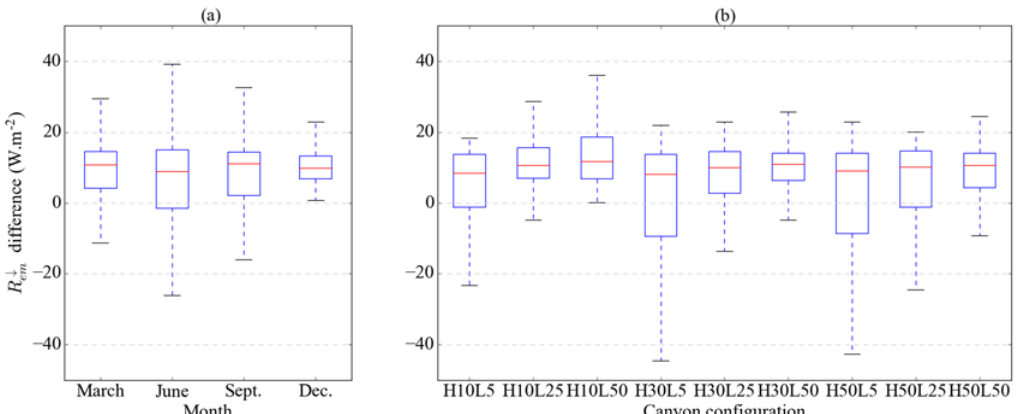
Figure 10. Distribution of the differences between hourly scene emitted radiation estimated integrating the 3D geometry and assuming a flat surface, by month ( a ) and by canyon configuration ( b ). The red line being the median value, the upper and lower limits of the box the upper and lower quartile respectively and the whiskers representing the minimum and maximum values.